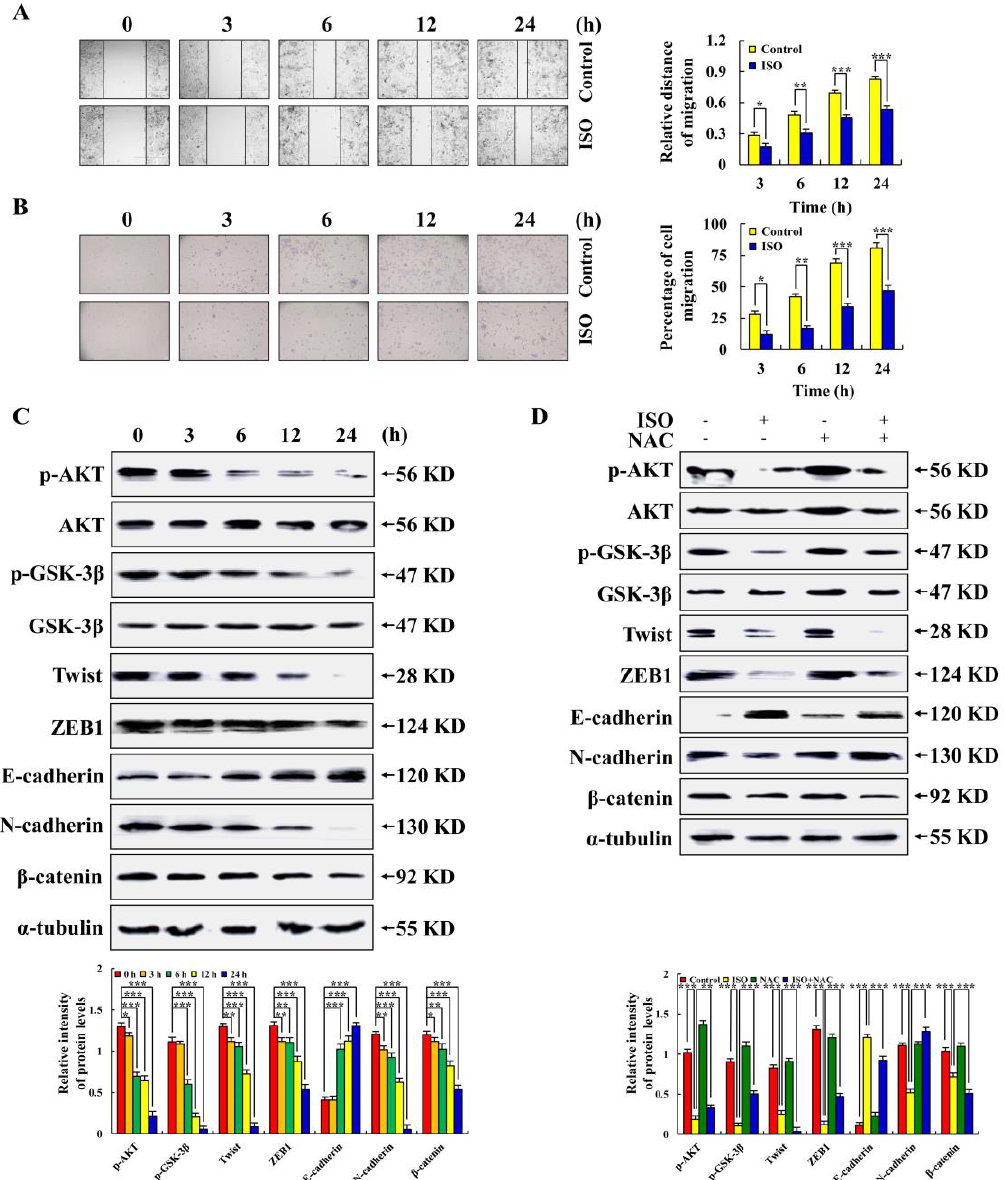
Figure 6. The inhibiting effects of ISO on migration in AGS cells. A total of 36.54 µ M ISO was applied to AGS cells from 0 to 24 h. ( A ) Migration changes in AGS cells were observed by fluorescence microscope (original magnification, × 200). ( B ) The number of AGS cell migration was observed by fluorescence microscope (original magnification × 400). ( C ) Migration related protein expression level. ( D ) Expression of migration related proteins of AGS cells treated with ISO (36.54 µ M) and/or NAC (10 mM), and α –tubulin was used as an internal reference protein. * p < 0.05, ** p < 0.01 and *** p < 0.001 vs. 0 h or NAC +